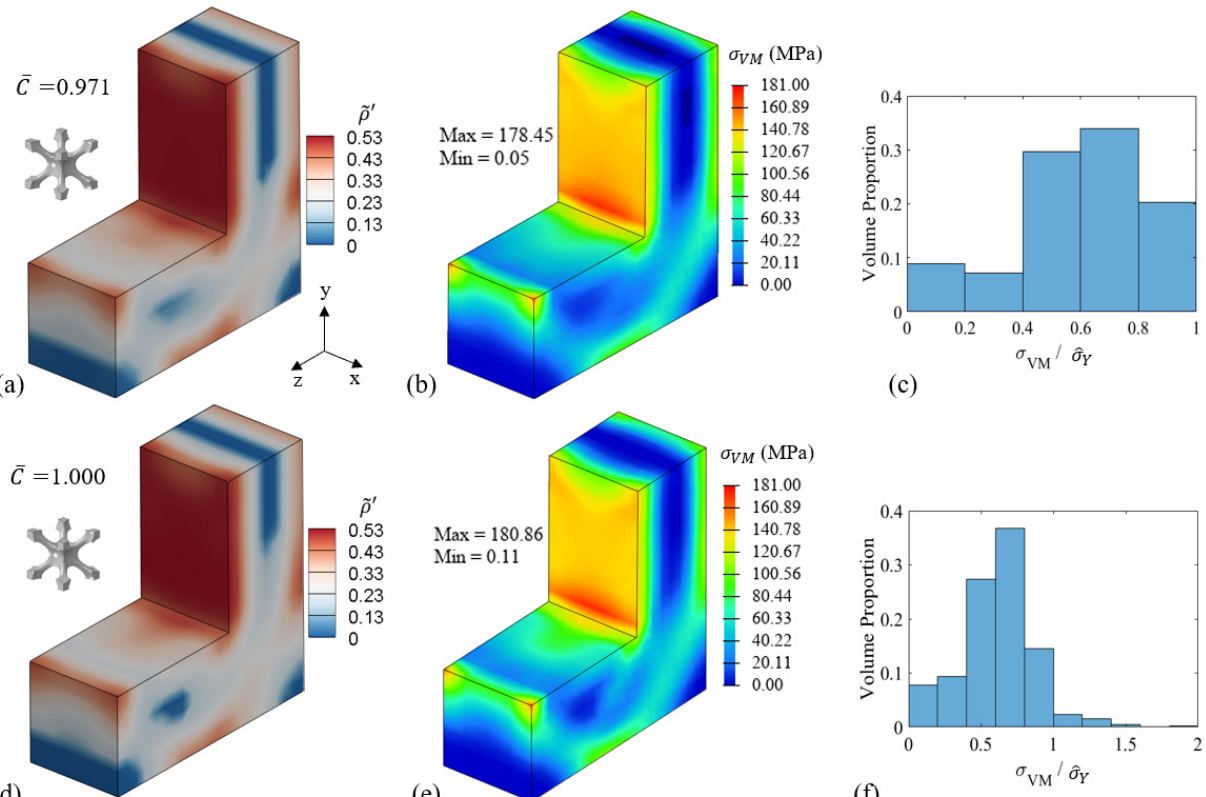
Figure 15. Optimisation results of the BCC-F L-shaped beam bending case study with problem P v f = 0.25 : distributions of ( a ) optimised relative density ( C is normalised optimised compli- ance) and ( b ) von Mises stress, and ( c ) the volume proportion histogram of stress constraint mea- surement ( σ VM /ˆ σ Y ) with the yield stress constraint applied; distributions of ( d ) optimised relative density and ( e ) von Mises stress, and ( f ) the volume proportion histogram of σ VM /ˆ σ Y without yield stress constraint.